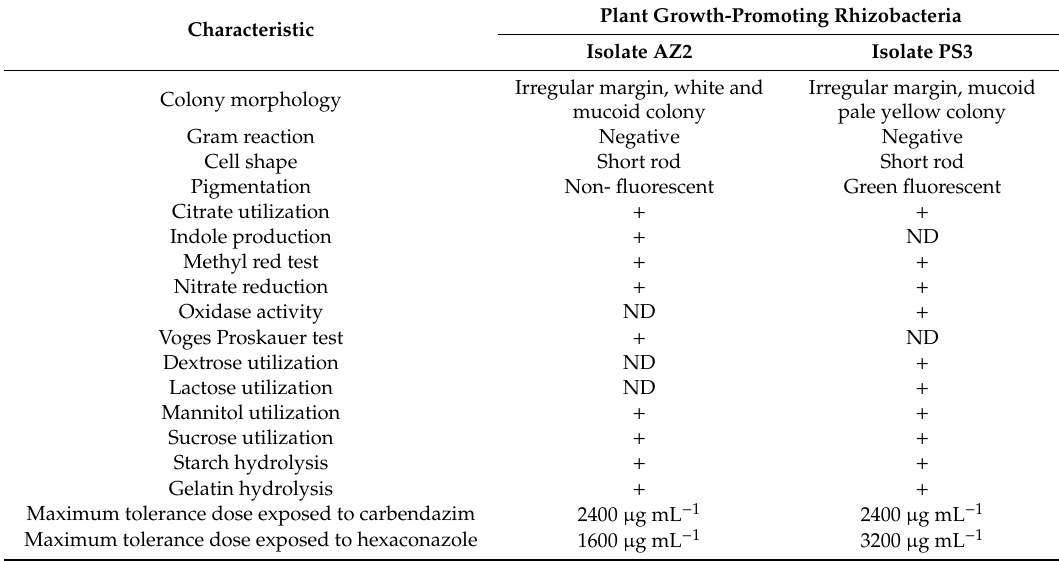
Table 1. Morphological and biochemical characteristics of plant growth-promoting rhizobacteria. Characteristic Colony morphology Gram reaction Negative Cell shape Pigmentation